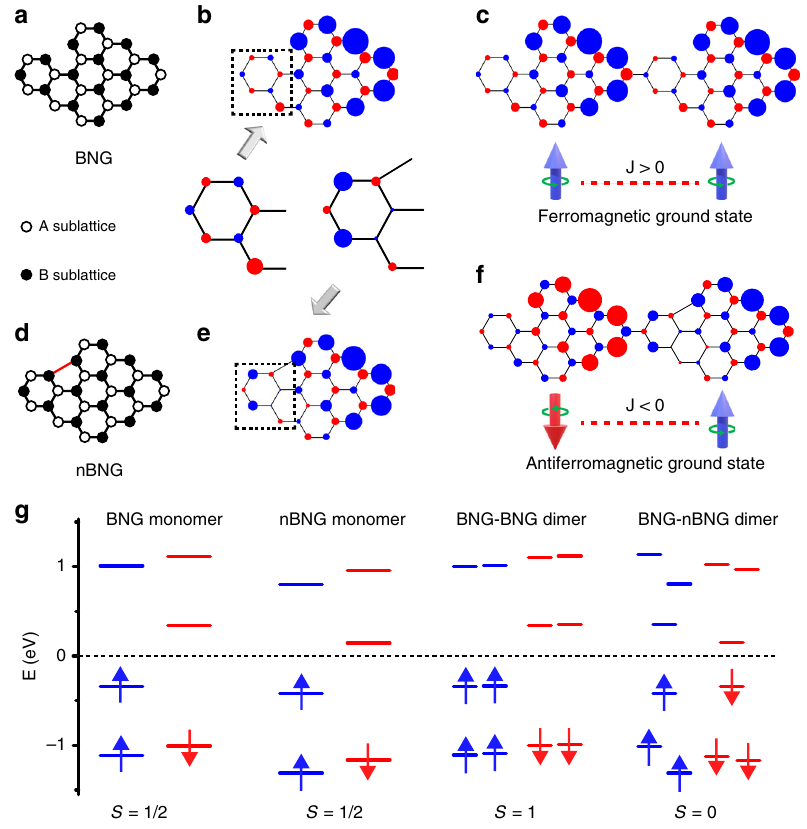
Fig. 1 Controlling spin order in diradical nanographenes via breaking sublattice symmetry. a , Atomic structure of a rhombic bipartite nanographene with a net spin of S = 1/2 due to sublattice imbalance. b Spin density distribution of the nanographene in a . c Spin density distribution of a diradical BNG – BNG dimer, exhibiting a ferromagnetic coupled ground state. d Atomic structure of a nonbipartite nanographene with the red C – C bond breaking the bipartite sublattice symmetry of nanographenes. The nonbipartite nanographene also hosts a net spin of S = 1/2. e Spin density distribution of the nanographene in d . The presence of fi ve-member ring causes a spin density sign reversal near the red bond, as highlighted by a dashed box. f Spin density distribution of a diradical BNG – nBNG dimer, showing an antiferromagnetic coupled ground state. g Energy level fi lling of the above four con fi gurations. Blue/red isosurfaces denote spin up/spin down density,